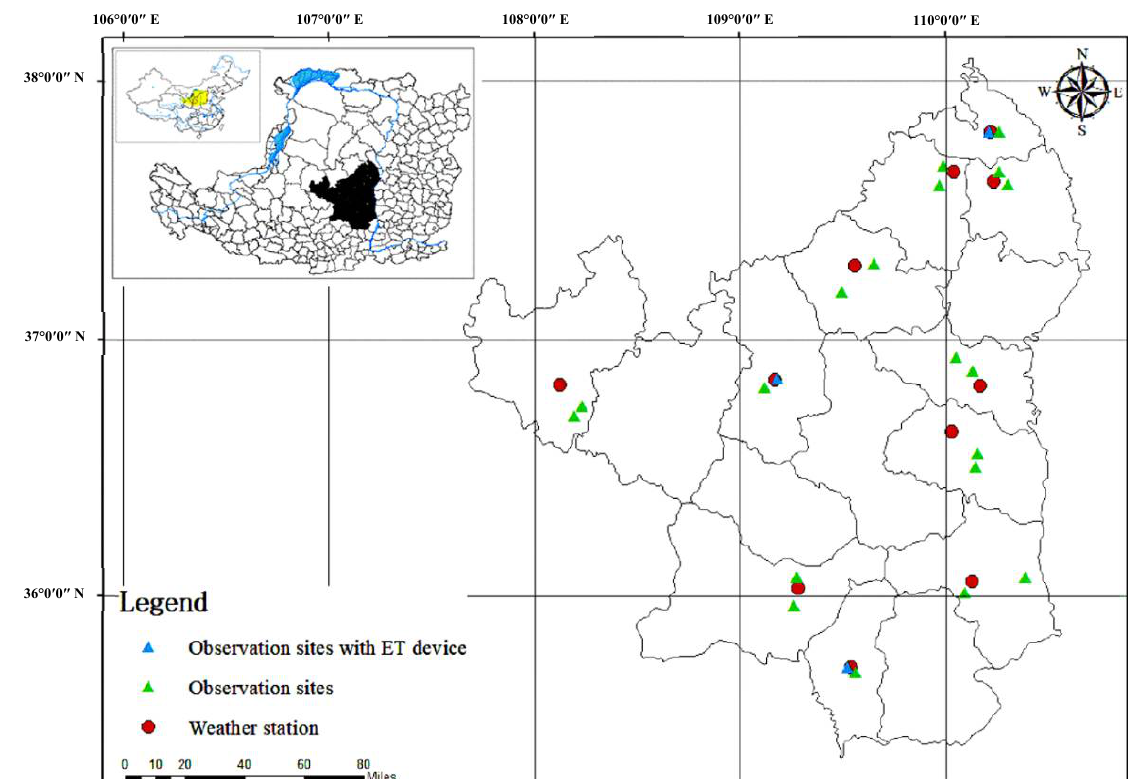
Figure 1. Location of weather station and observation sites in the studies zone of the Loess Plateau.